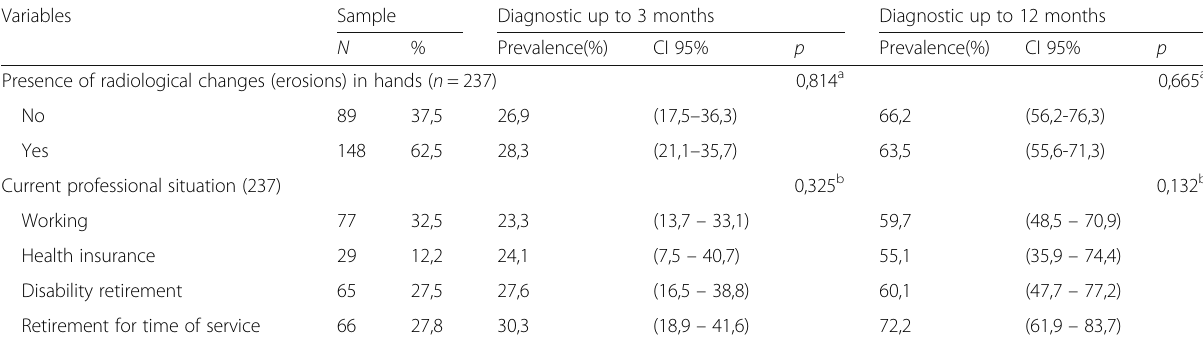
Table 1 Description of the sample and the prevalence of the diagnostic time of up to 3 and 12 months of symptons according to the independente variables in patients with rheumatoid arthritis of Blumenau, Santa Catarina, Brazil, 2014